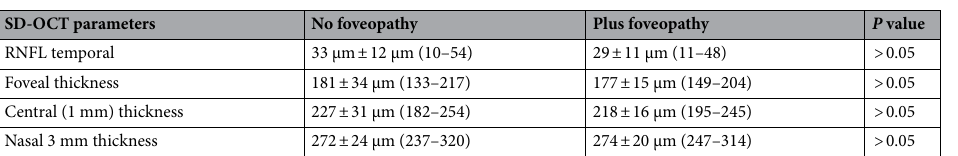
Table 2. Summary of SD-OCT parameters between the two groups: isolated dominant optic atrophy versus dominant optic atrophy plus foveopathy.